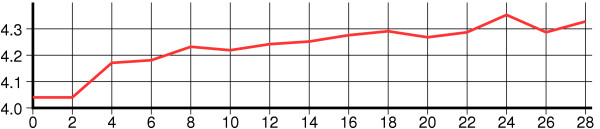
Sums of average unweighted log-odds scores with weighted log-odds scores for different values of L. The value for L = 0 corresponds to NCL.